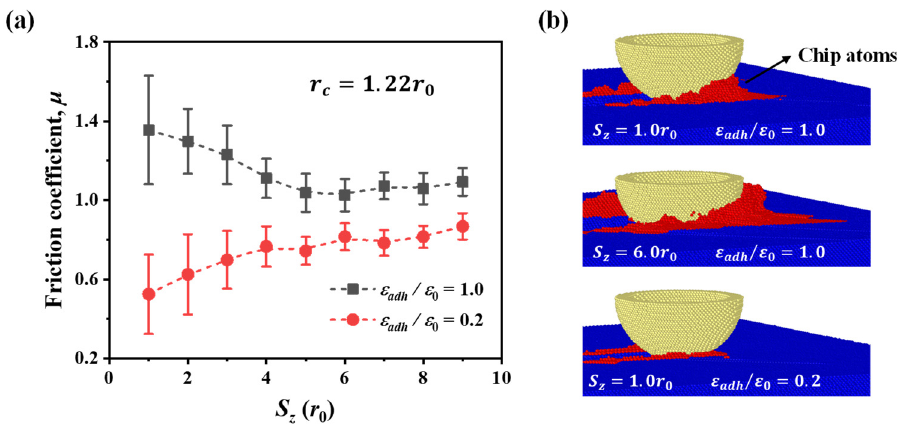
Figure 5. ( a ) Friction coefficient for two adhesion ratios at different scratch depths. ( b ) Atomic configuration at the scratch distance of 45 r 0 .